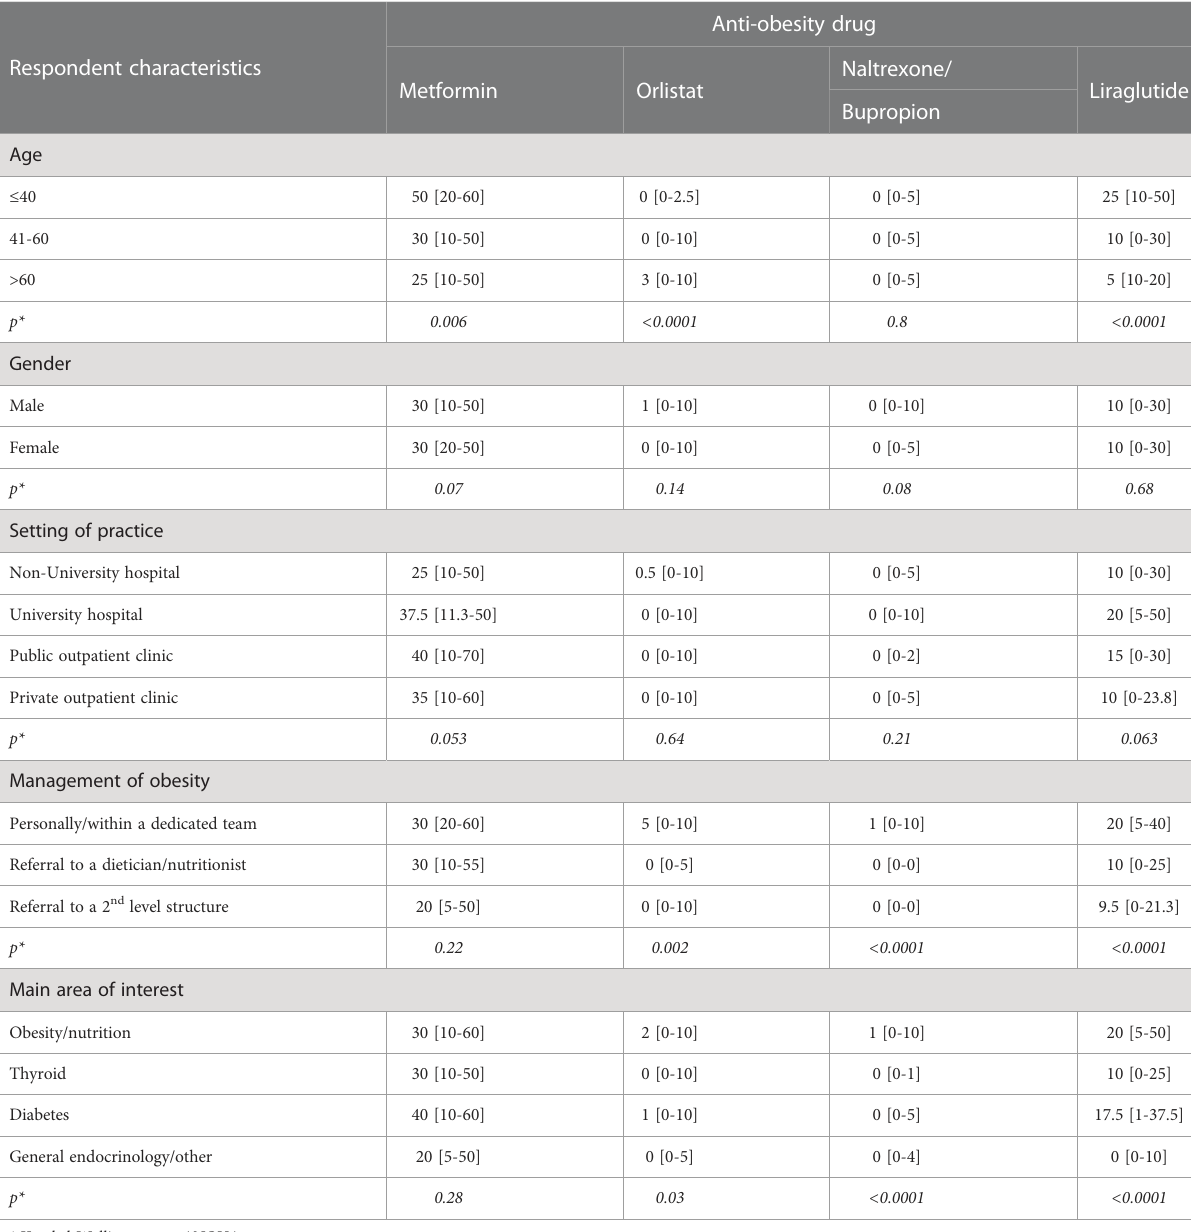
TABLE 5 Rate of prescription of different anti-obesity drugs by respondent characteristics (median and IQR